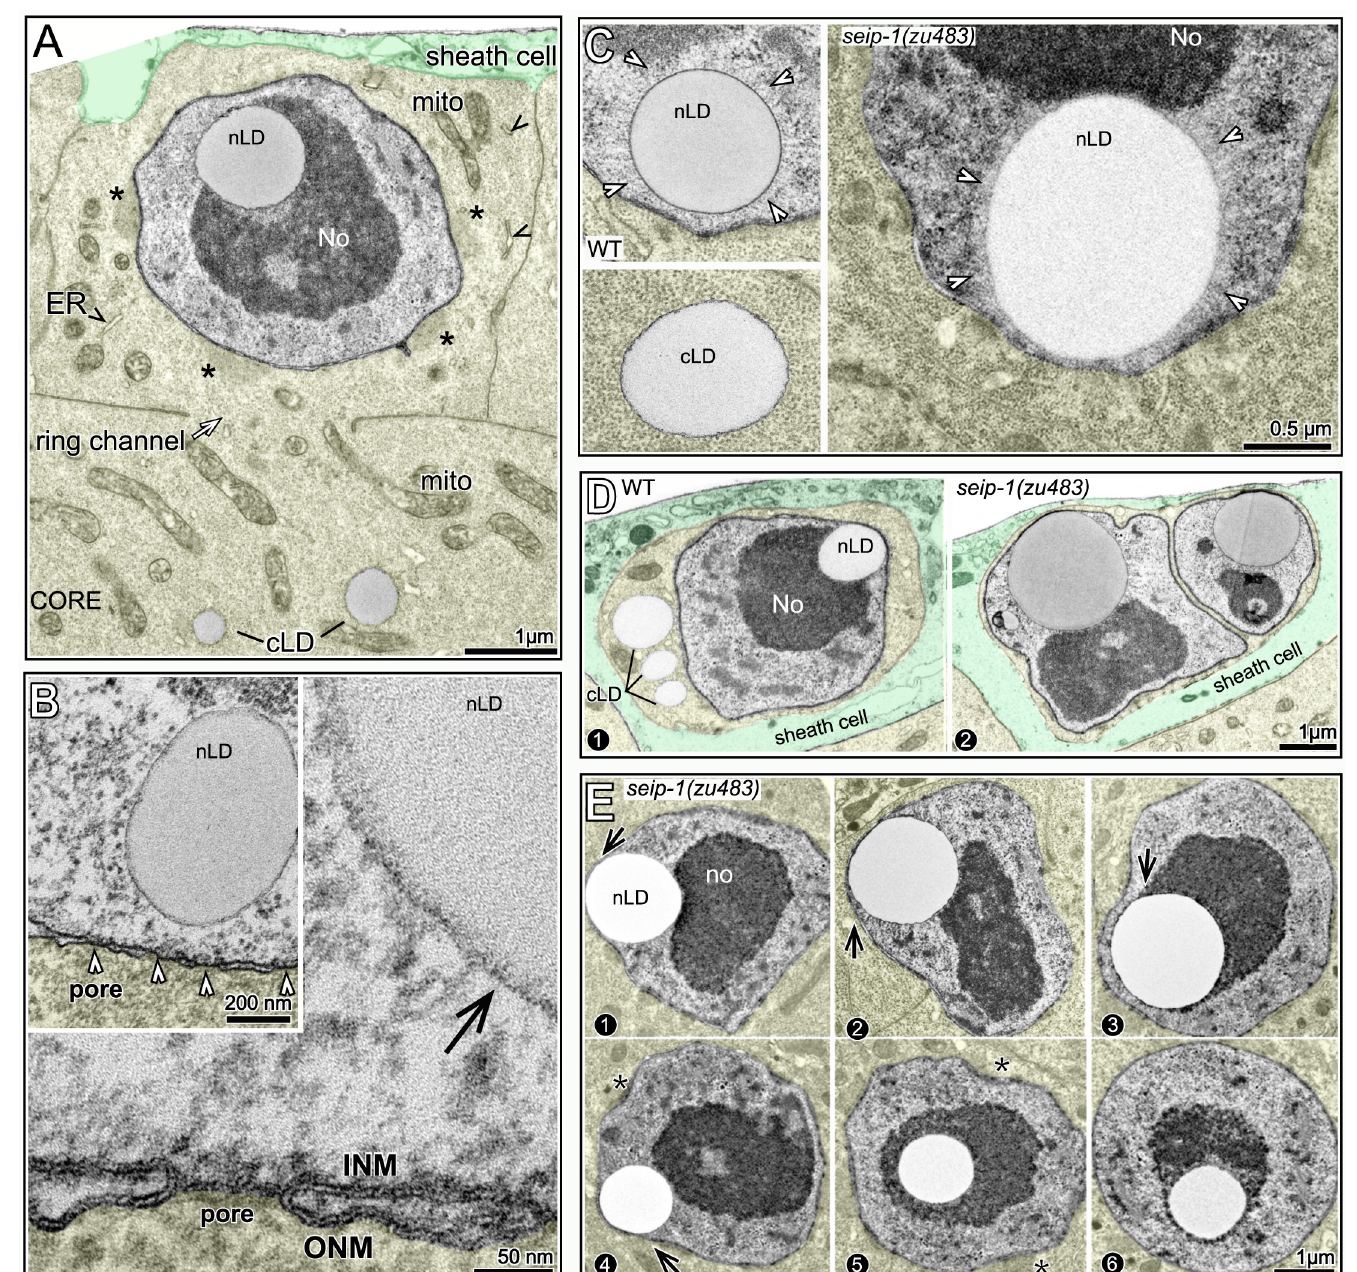
Fig 11. TEM of germ cell nLDs. (A) TEM of a D1 gonad showing a pachytene germ cell with an nLD; the germ cell cytoplasm is tinted yellow, except for cLDs, and a gonad sheath cell is tinted green. The nucleus is approximately spherical, except for small, flattened regions by perinuclear, germ cell-specific granules called P granules (asterisks). The germ cell cytoplasm contains mitochondria (mito) but few ER profiles (arrowheads, see also S8 Fig). For this analysis, we dissected the peak nLD zone from D1 and D2 gonads as described for Fig 10H . 62/347 pachytene germ cells from this zone contained nLDs; most nLDs appeared to be about 0.5 μ m in diameter, but a few were over 1 μ m. Of 55 non-apoptotic cells with nLDs, 51 had a single nLD, 3 had two nLDs, and 1 had three nLDs. (B) Comparison of the surface of an nLD (black arrow) with the lipid bilayer membranes of the INM and ONM in the same nucleus. Note that the nLD directly abuts nucleoplasmic materials, with no evidence of a heterochromatin coat (compare with intestinal nLDs in Fig 2F ). (C) TEM of nLDs with bristle coats (arrowheads) in wild-type and seip-1(zu483) mutant germ cells. The bristle coat separates the nLD from other nucleoplasmic materials, and is not present on cLDs. (D) Images of nLDs in apoptotic germ cells in wild-type and seip-1 (zu483 ) gonads. The apoptotic cells are shrunken and engulfed by phagocytic sheath cells (green tint). The wild-type cell has three cLDs, presumably because it had begun to fill with core cytoplasm before shrinkage. Note that the seip-1 mutant cell is binucleate; binucleate cells occur in wild type gonads and are removed by apoptosis. (E) Pachytene germ nuclei with large nLDs. Note bulges (arrows in panels 1–4) where nLDs abut the envelope. Nuclei with central nLDs are spherical, expect for small indentations at the site of P granules (asterisks, see also Fig 11A ).